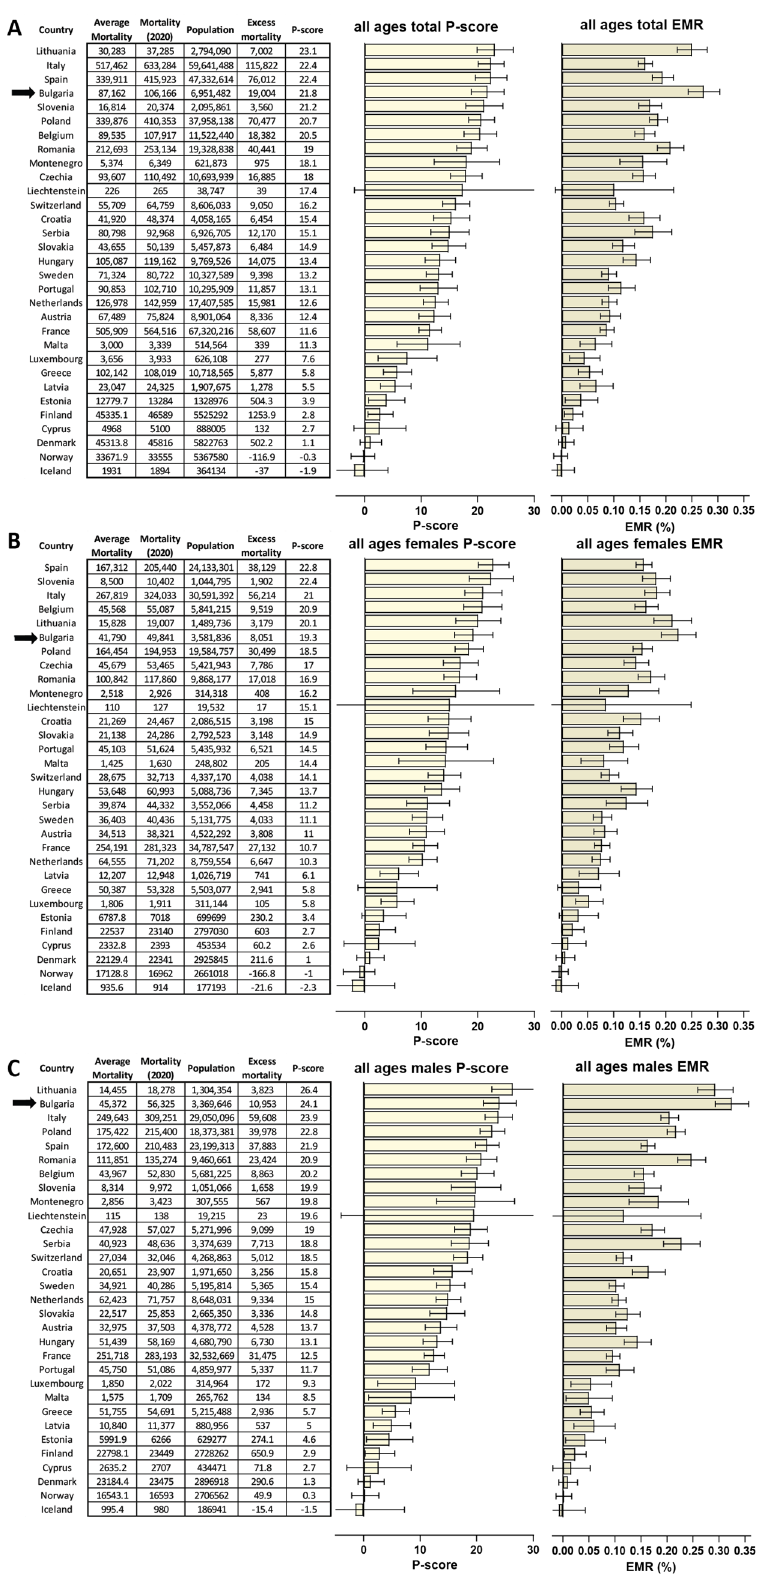
Figure 1. Excess mortality in Bulgaria and other European countries in 2020. ( A ) Overall P-scores and excess mortality (in deaths per million; DPM) for all ages in Bulgaria (highlighted in red) and other European countries; ( B ) P-scores and excess mortality for females of all ages; ( C ) P-scores and excess mortality for males of all ages. All error bars in this and subsequent figures represent 95% confidence